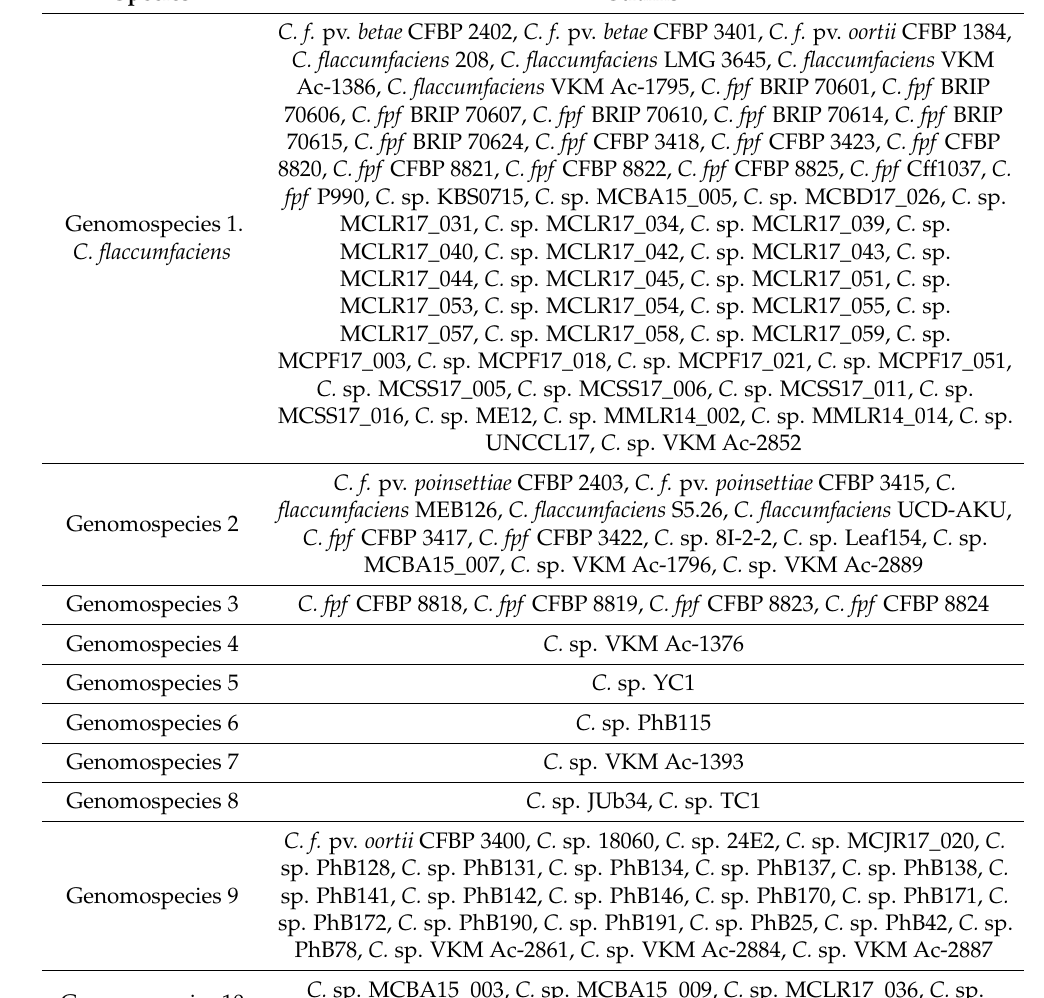
Table 2. Suggested Curtobacterium species based on the genomic data. Species Strains